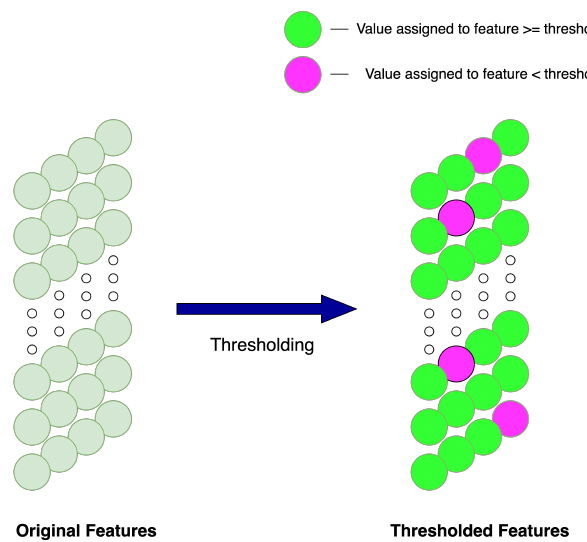
Figure 2. Illustration outlining the feature thresholding